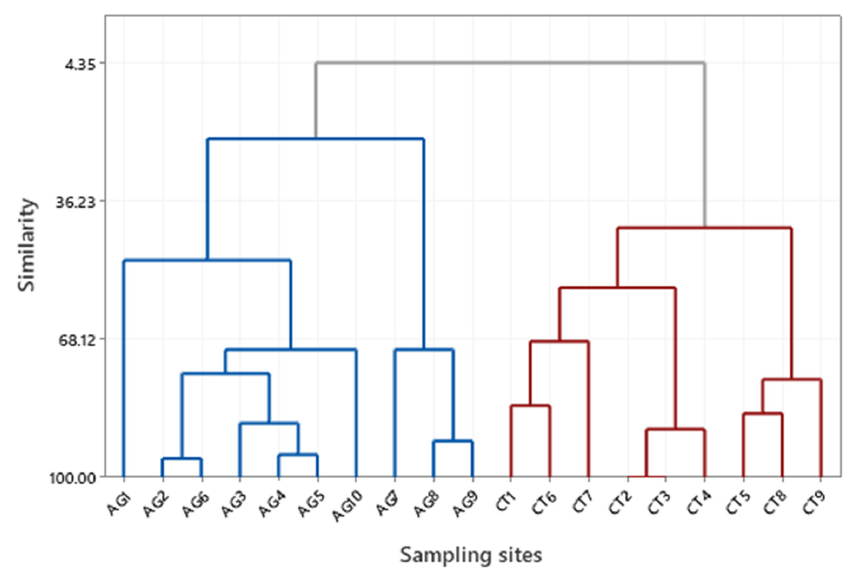
Figure 3. Clustering monitoring sites in the Hau River in 2019.